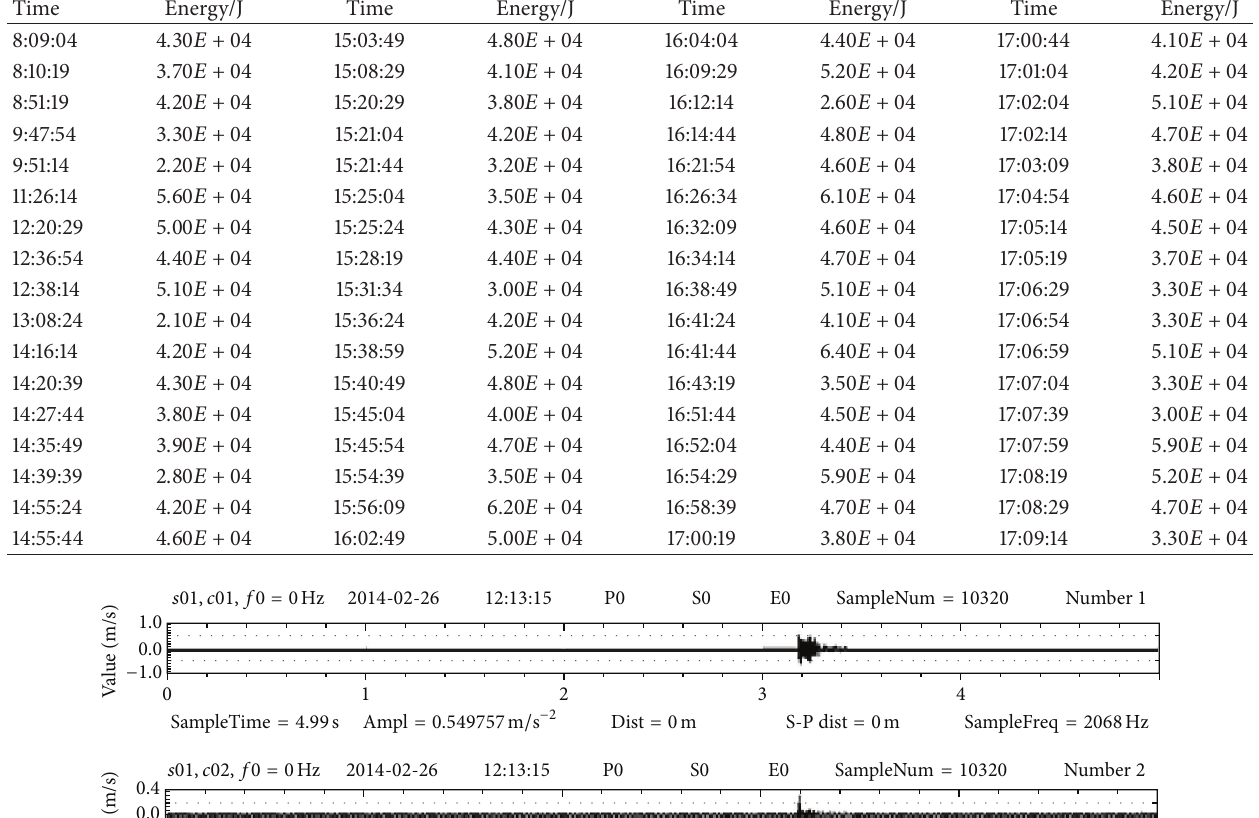
Table 2: Microseismic monitoring data on the 20th of April. Time Energy/J